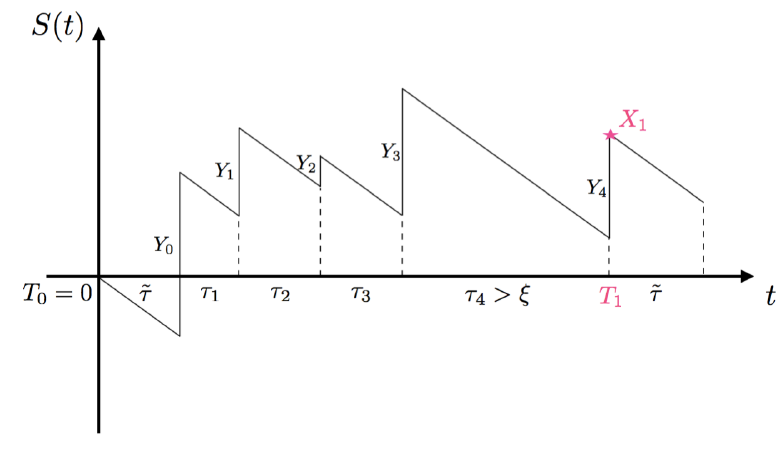
Figure 2. A sample path of the regenerative